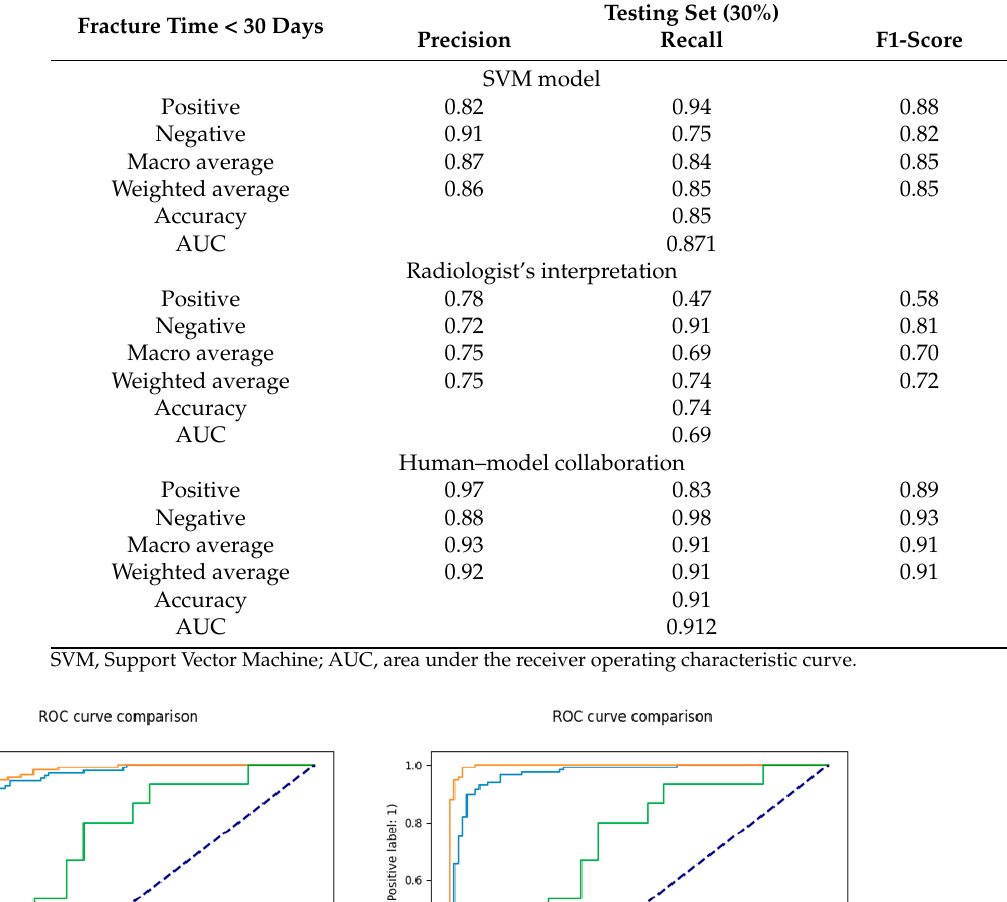
Table 2. Performances of the radiomics-based model, radiologist’s interpretation, and human–model collaboration for the testing set in predicting rib fracture at 30 days.